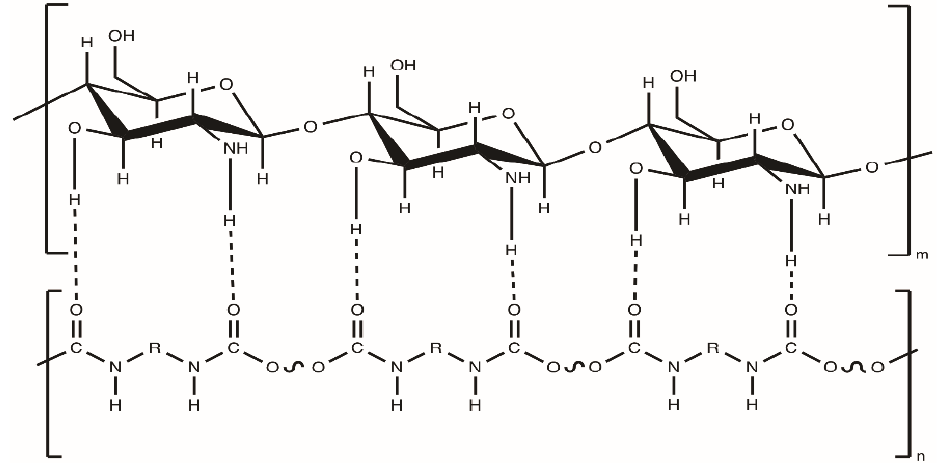
Figure 3. Scheme of proposals of hydrogen interactions between the polyurethane chain and a chitosan particle.